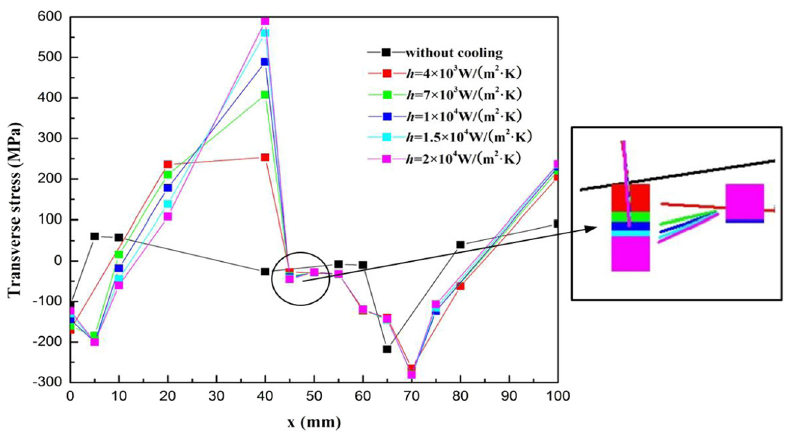
Figure 11: Transverse stress distributions along weld center line of di ff erent cooling intensities when t = 30 s.